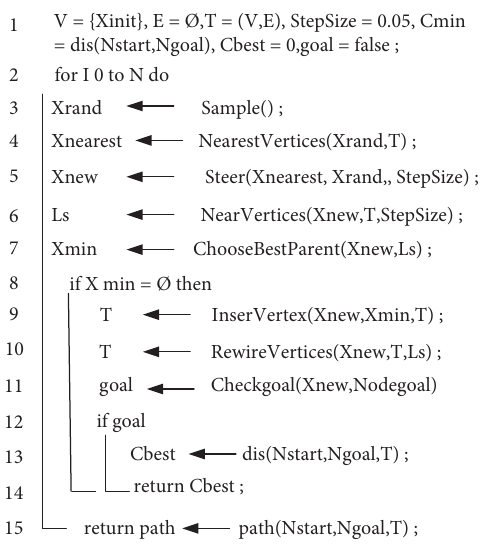
Figure 4: Informed-RRT ∗ algorithm